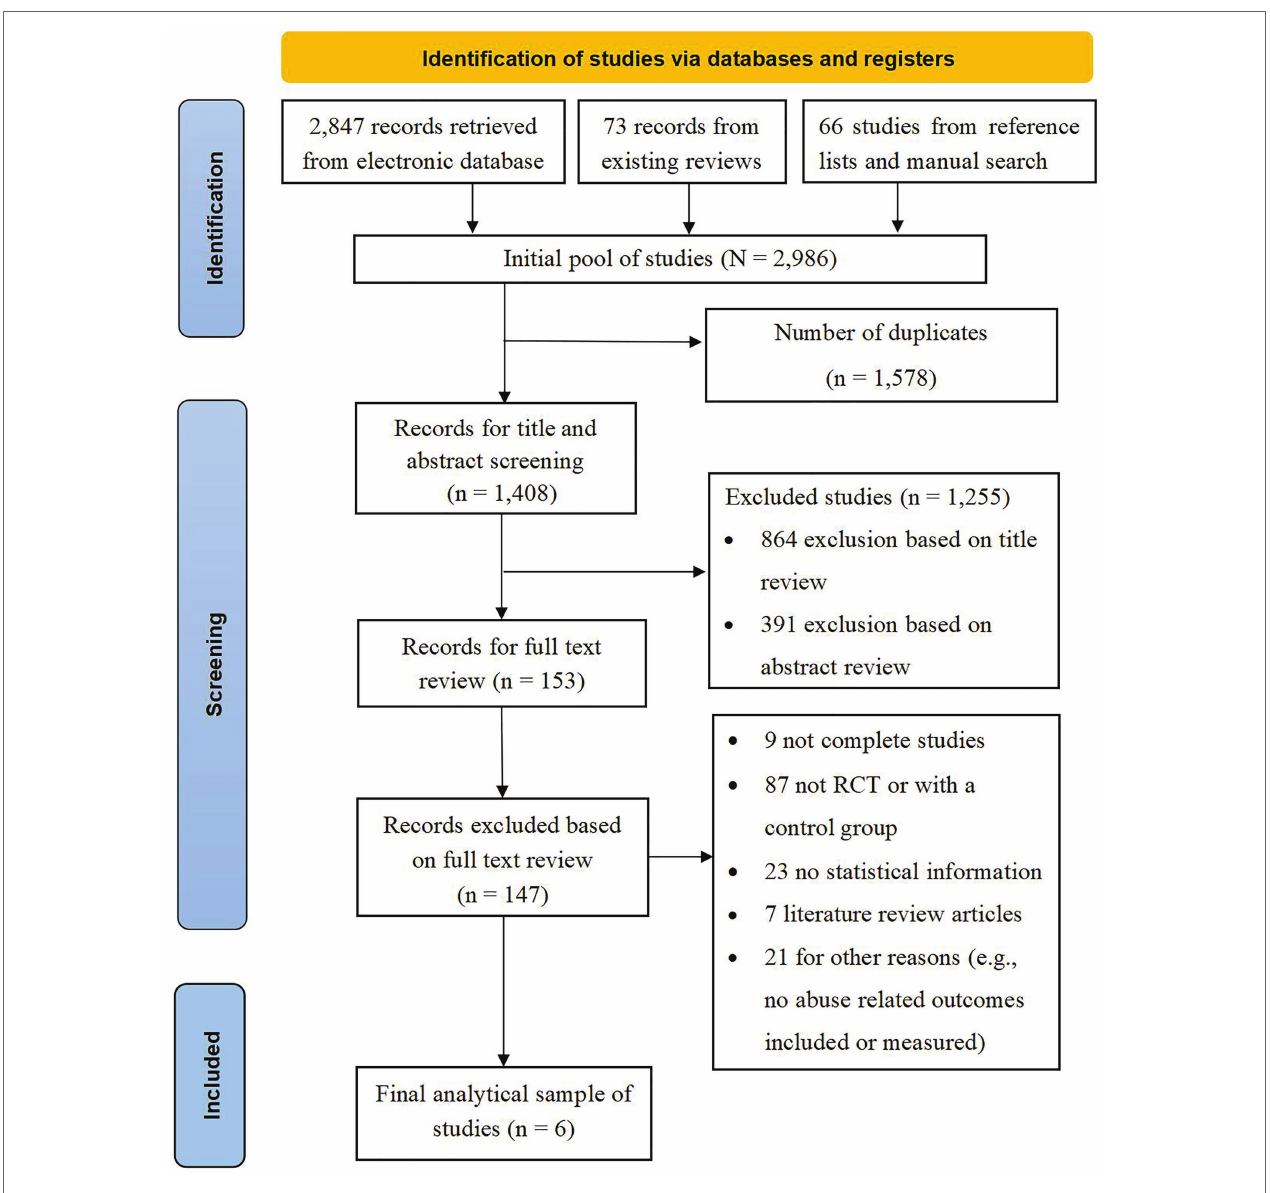
FIGURE 1 | PRISMA chart of literature